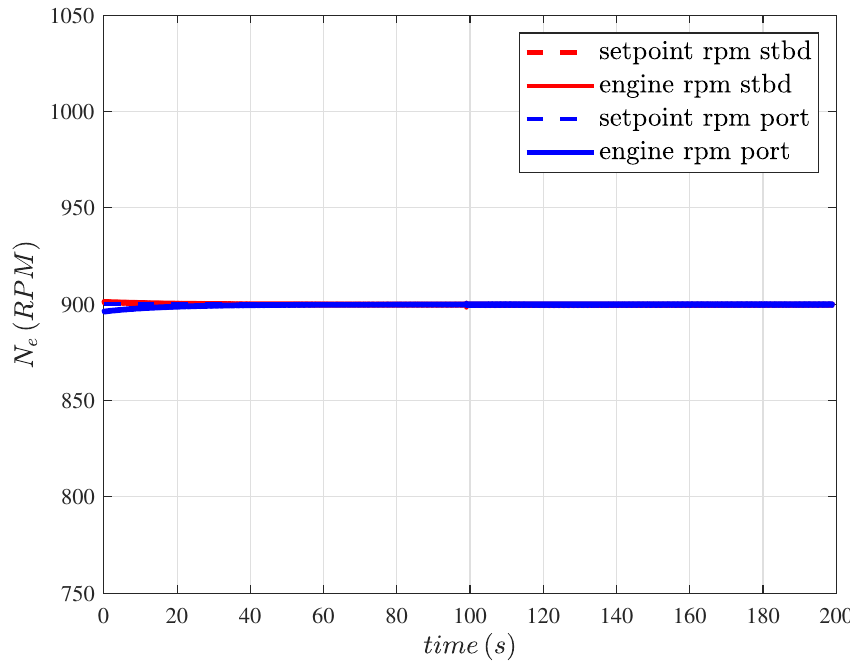
Figure 9. Engine shaft speed setpoint and feedback.